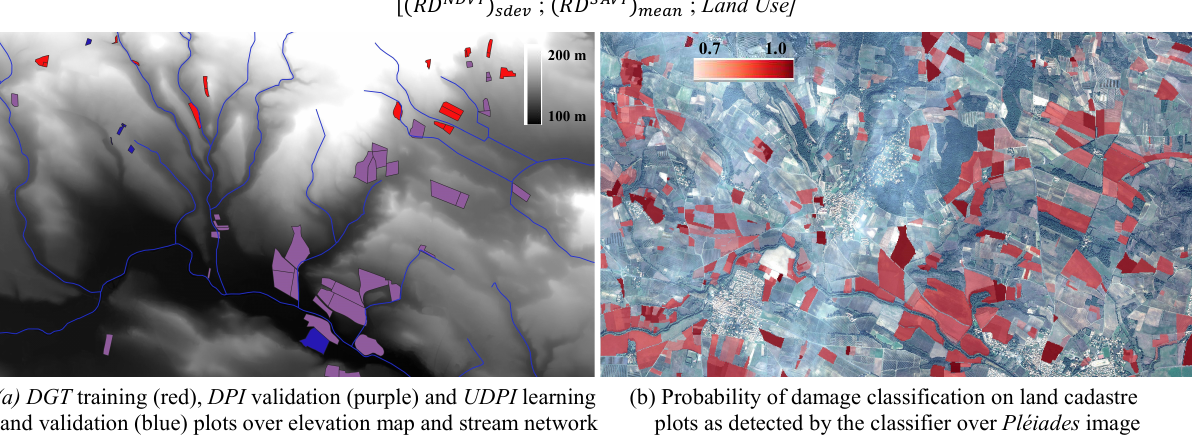
Figure 9. Close-up from the north-west of Carcassonne displaying the probability of damage classification by Gaussian